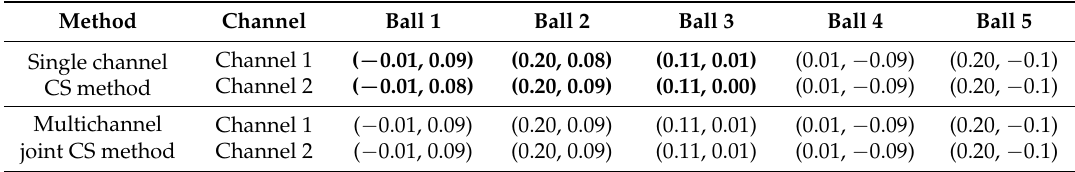
Table 1. The reconstructed positions of each metal ball by different CS-based methods using full data.